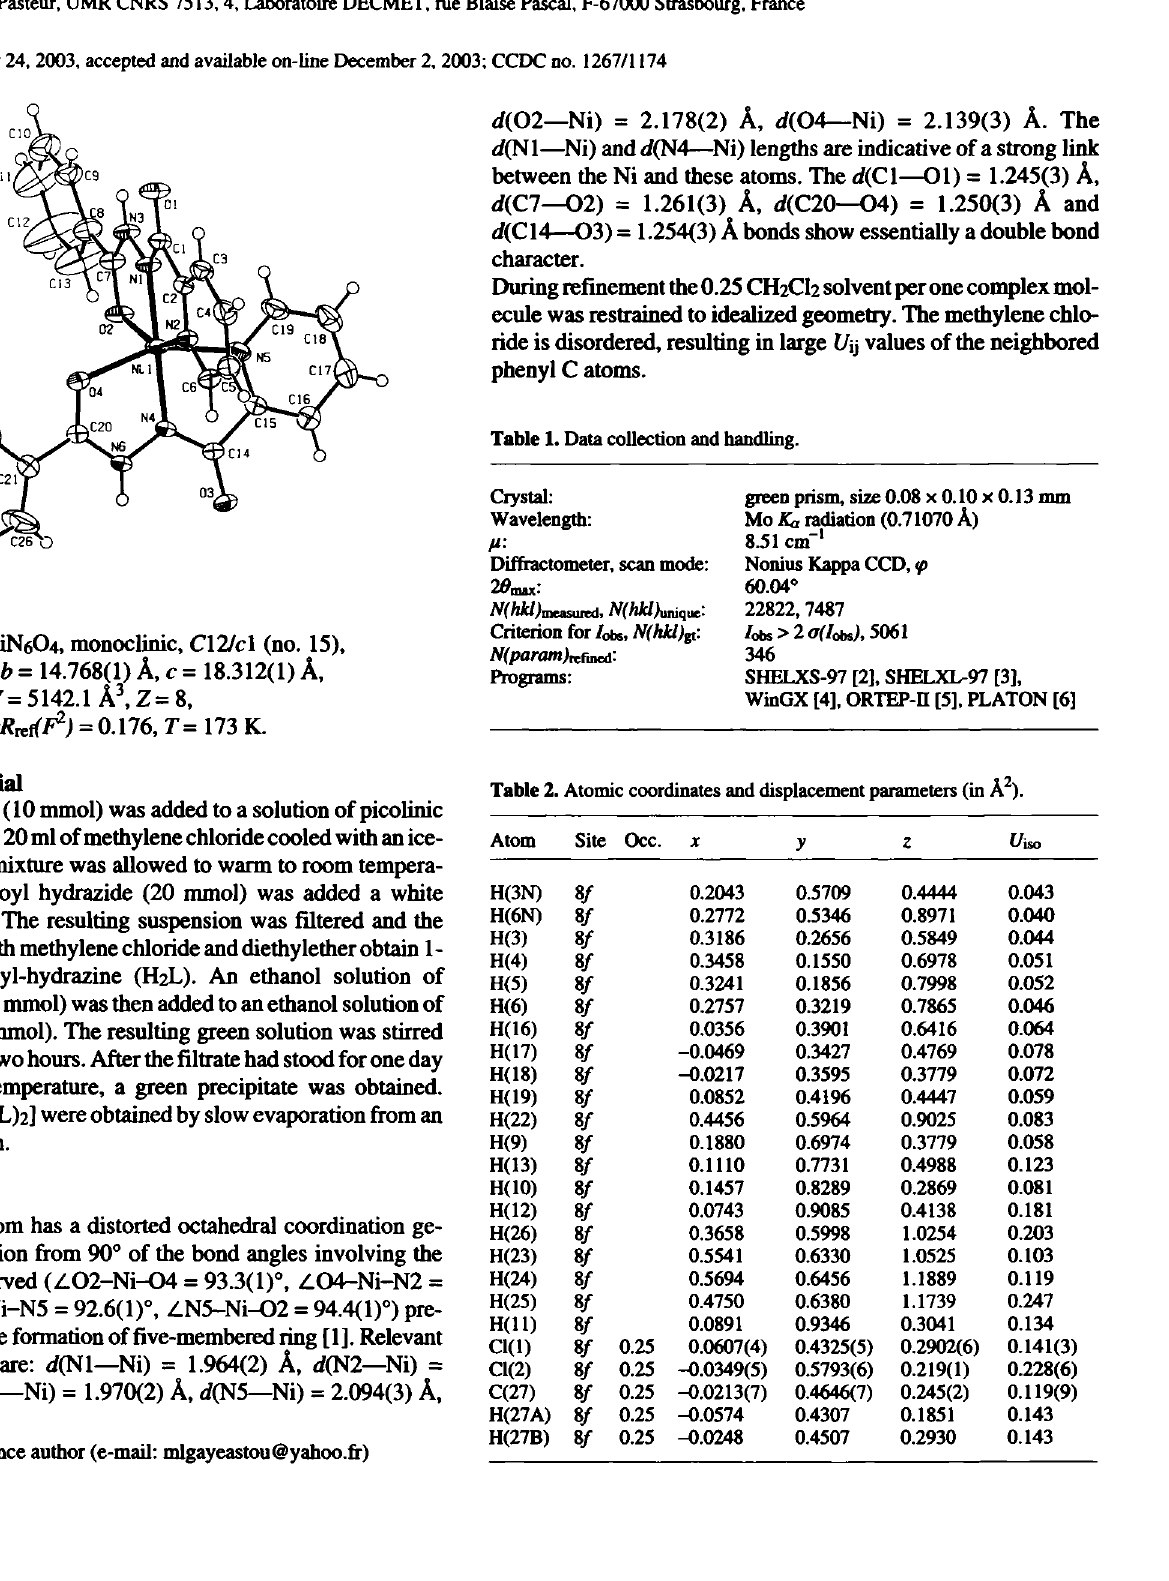
Table 1. Data collection and handling.